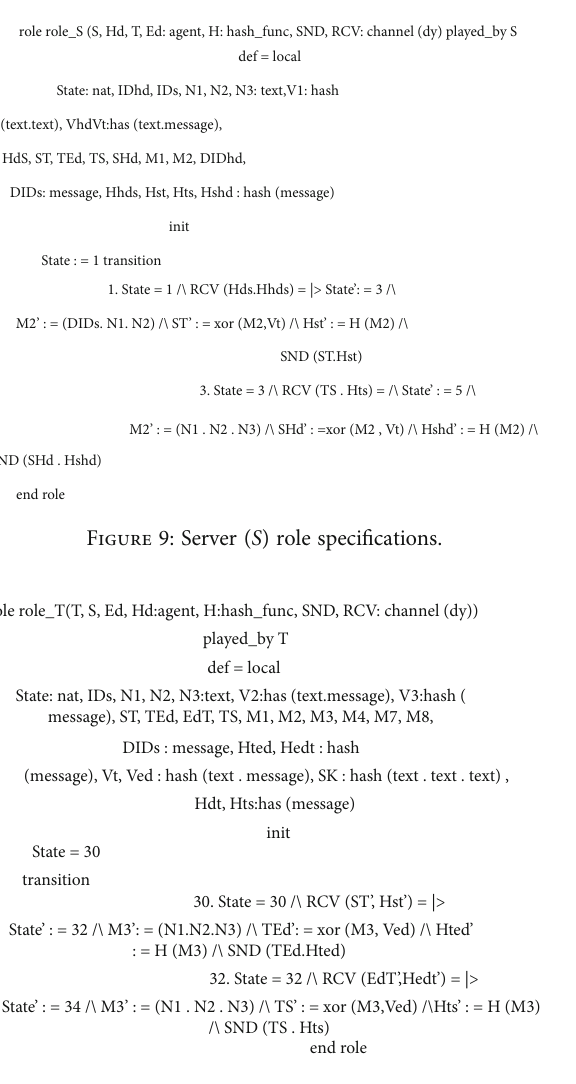
Figure 10: Transporter role speci fi